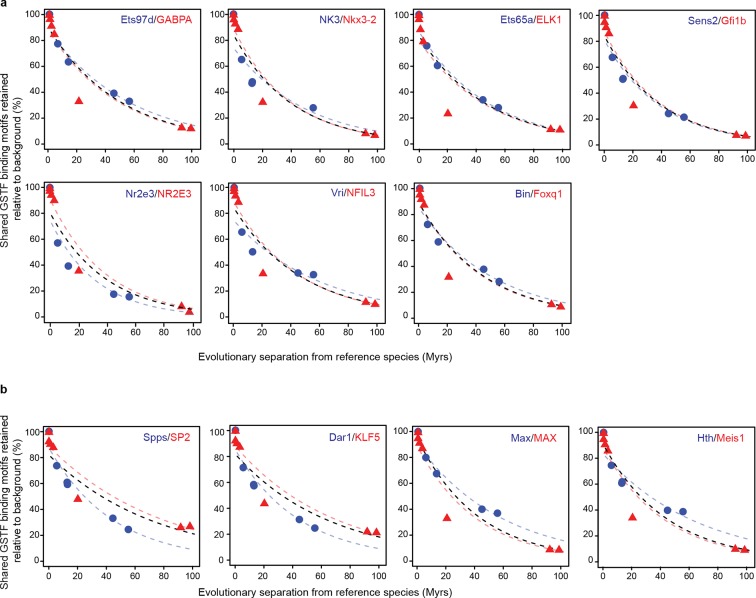
Conservation of cis-regulatory motifs for GSTFs conserved across insects and mammals.(a) Seven shared GSTFs whose motifs are retained at indistinguishable rates in mammals and insects. The evolution of these motifs behave similarly to that of the example shown in Figure 5. (b) Four conserved GSTFs whose motifs are retained at different rates in mammals and insects.